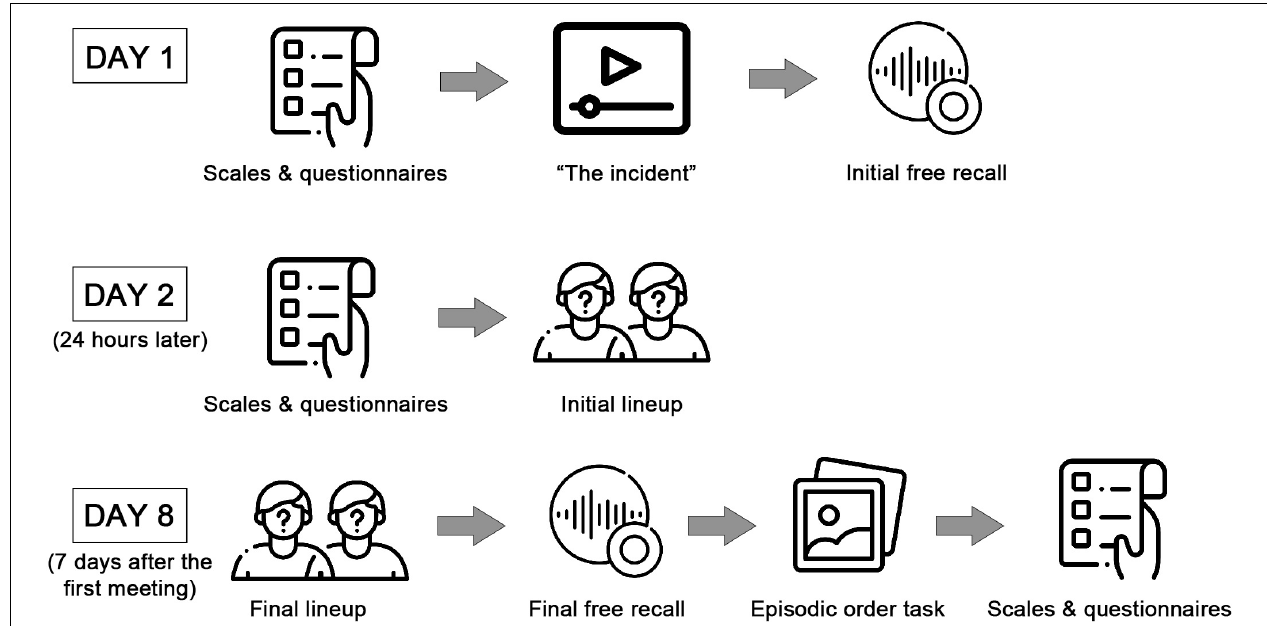
FIGURE 1 | Experimental procedures. The scales and questionnaires included the sociodemographic questionnaire, State-Trait Anxiety Inventory, Beck Depression Inventory (BDI-II), and the Pittsburgh Sleep Quality Index (PSQI). The incident stands for the video of a perpetrator entering a conference. The initial lineup was formed by the presentation of 6 photos where the perpetrator could be present (With perpetrator group) or absent (Without perpetrator group). During the final lineup 6 photos were shown, including the perpetrator’s. Icons “To do list,” “Video player,” “Recording,” “Suspect,” and “picture” made by Freepik [https://www.flaticon.com/authors/freepik] from